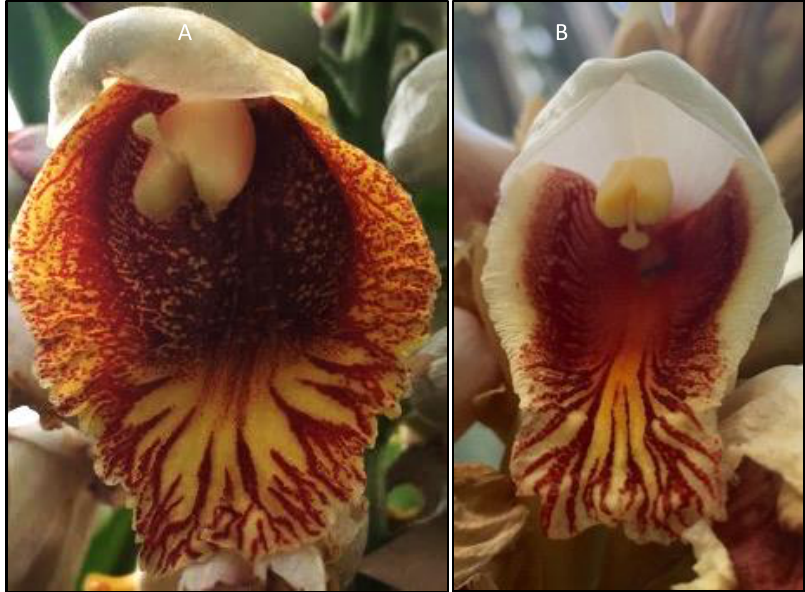
Figure 1. Flexistyly in Alpinia. ( A ) Cataflexistylous morph (style curved above the anther along with anther dehiscence) ( Alpinia cf. malaccensis ). Picture taken at 10:22 h. ( B ) Anaflexistylous morph (style curved below the anther and no anther dehiscence) ( Alpinia roxburghii ). Picture taken at 10:30 h. Accessions photographed at the Royal Botanic Garden Edinburgh.